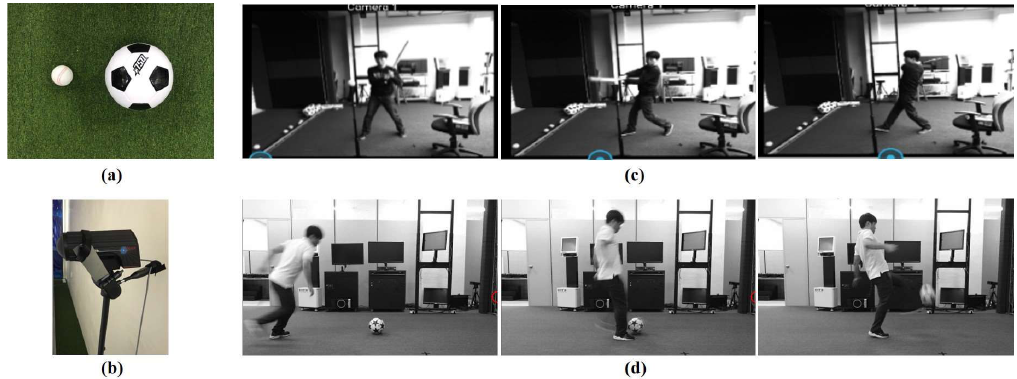
Figure 8. Speed estimations of balls: ( a ) a baseball (7.23 cm) and a soccer ball (22 cm); ( b ) Stalker Pro II sports radar gun as reference; ( c ) a sequence of baseball swings; and ( d ) a sequence of soccer ball kicks.